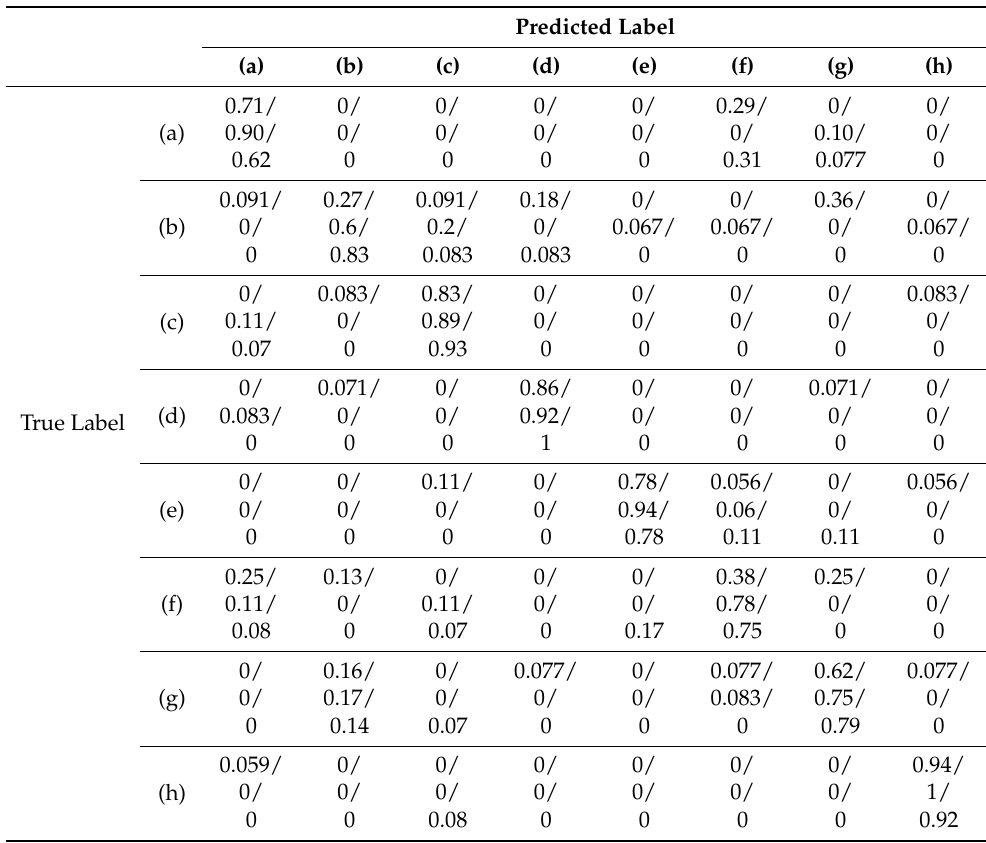
Table 3. Confusion matrix of the LSTM